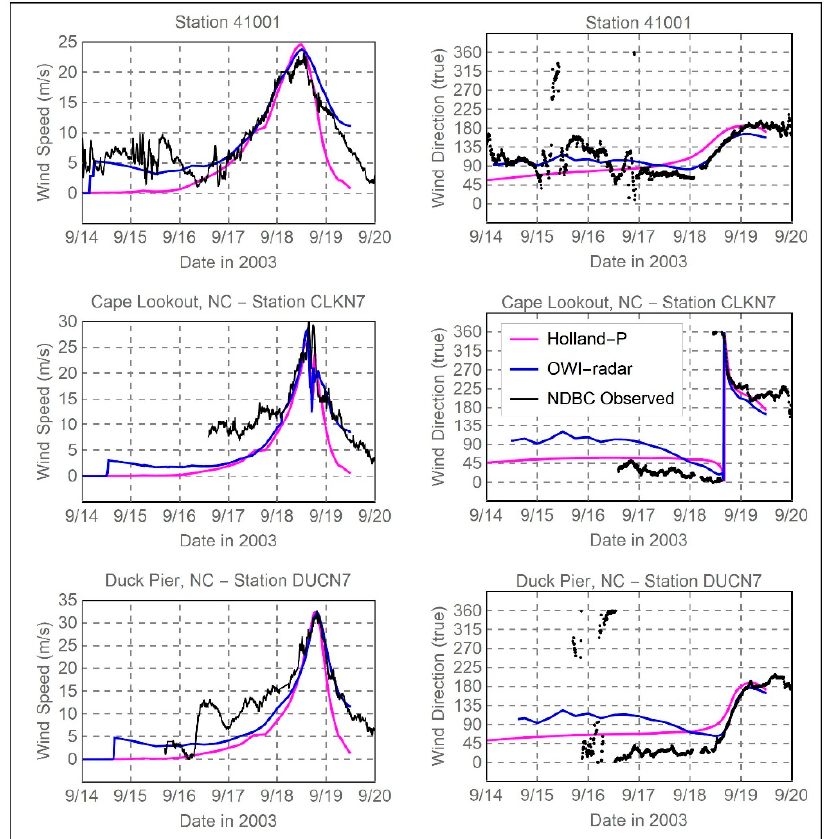
Figure 6. Wind speed and direction time series at the NDBC buoys in study area during Hurricane Isabel.